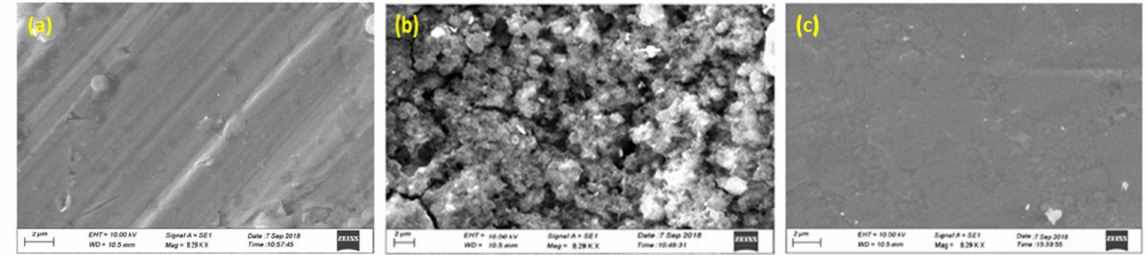
Figure 11. ( a ) SEM image of polished mild steel coupon before immersion in 1.0 M HCl, ( b ) SEM image of mild steel coupon after immersion in 1.0 M HCl (2 h), and ( c ) SEM image of polished mild steel coupon after immersion in 1.0 M HCl in the presence of 10% aqueous leaf extract of